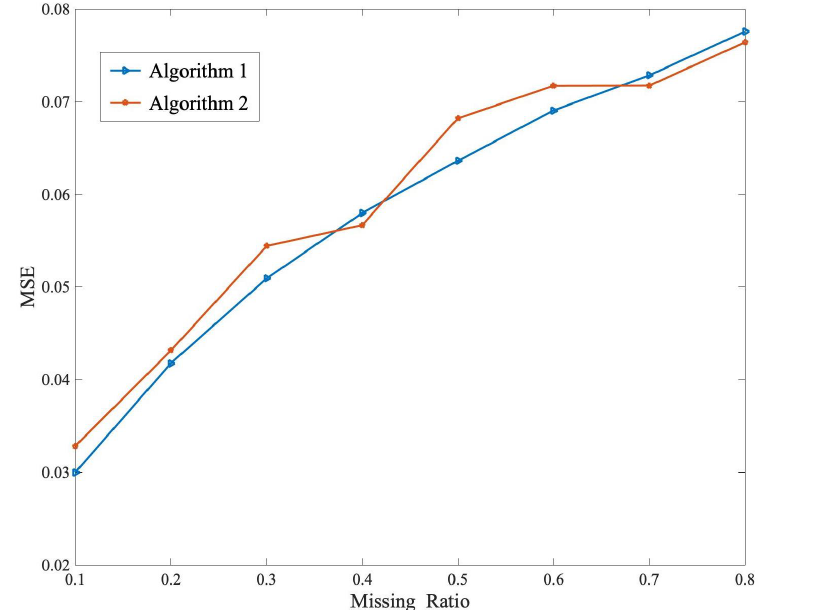
Figure 2. The MSE of two proposed methods under different missing